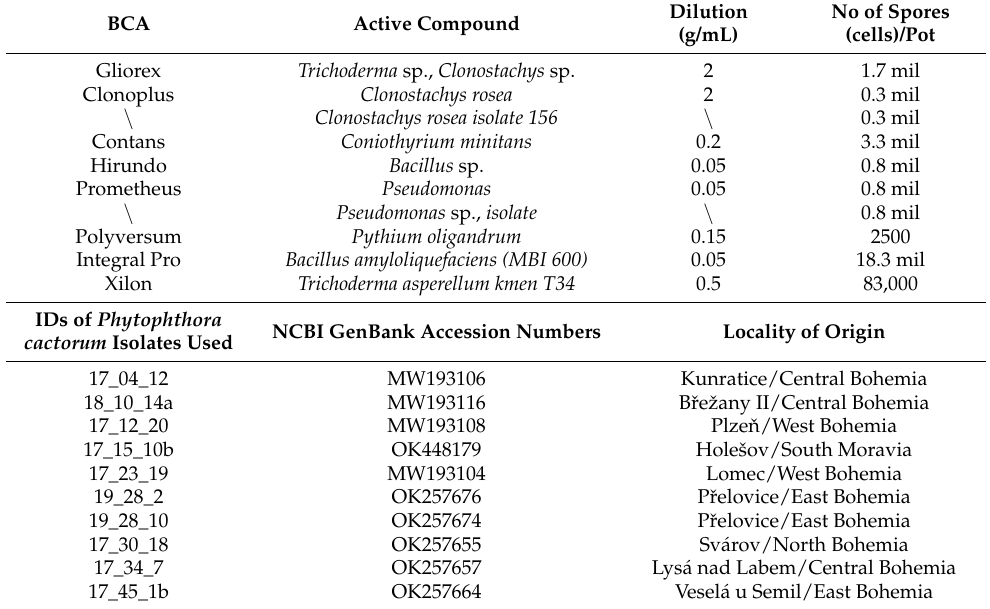
Table 1. Microorganisms used in